Question: What style of plot is this figure drawn as?
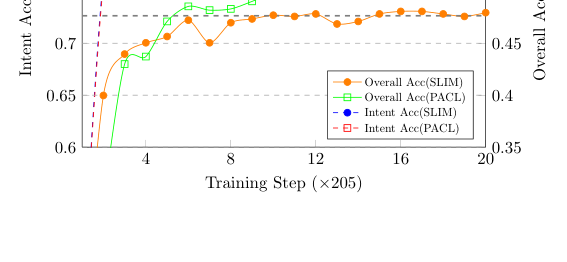
Answer: line